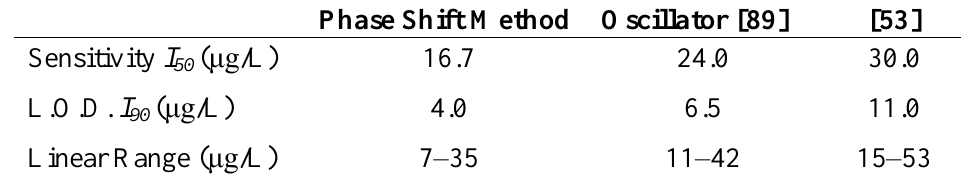
Table 1. Comparative results obtained for the QCM immunosensor using different electronic characterization